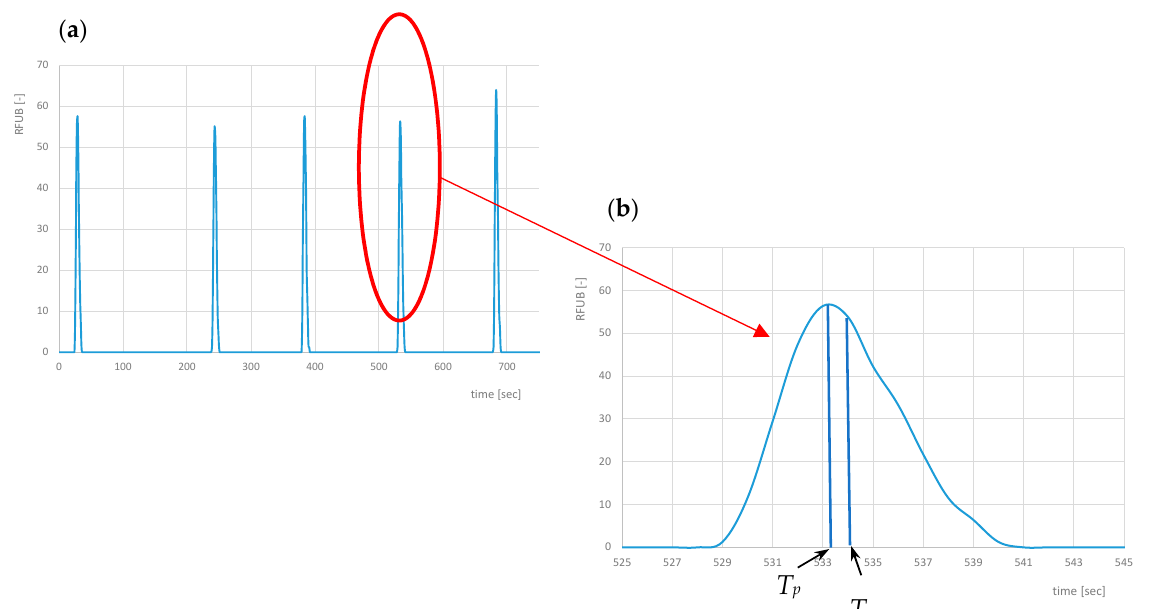
Figure 2. Example of ( a ) a dataset and ( b ) the detail of one experiment concentration distribution in time ( T p —peak time, T c —centroid time, RFUB—Raw Fluorescence Units Blanked).